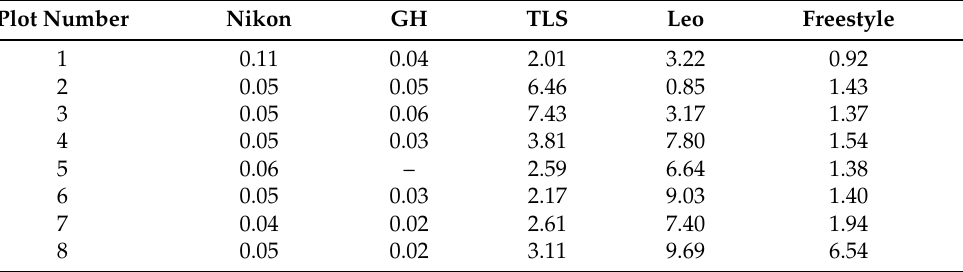
Table 11. Point cloud density expressed as mean horizontal distance to nearest point in millimetres. Plot